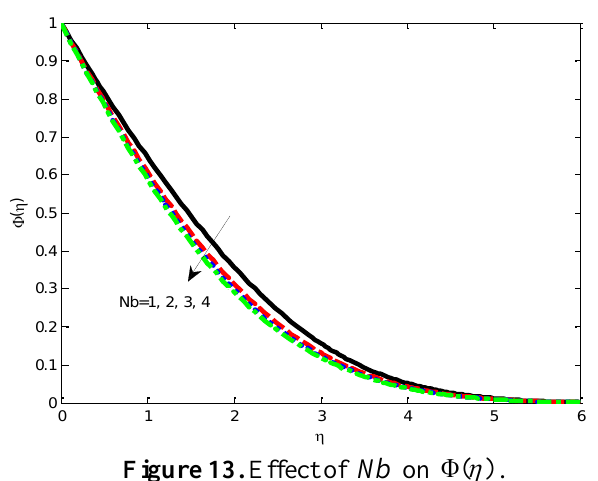
Figure 13. Effect of Nb on ( )  .